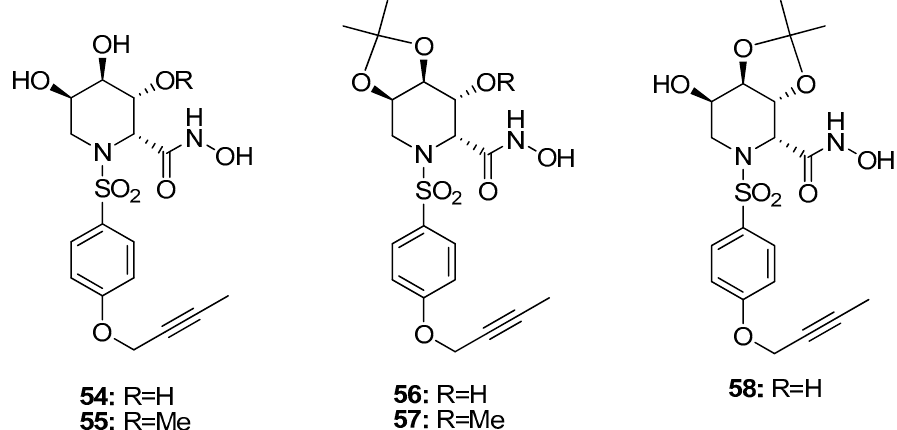
Figure 12. Chemical structure of azasugar-based TACE inhibitors ( 54–58 ).